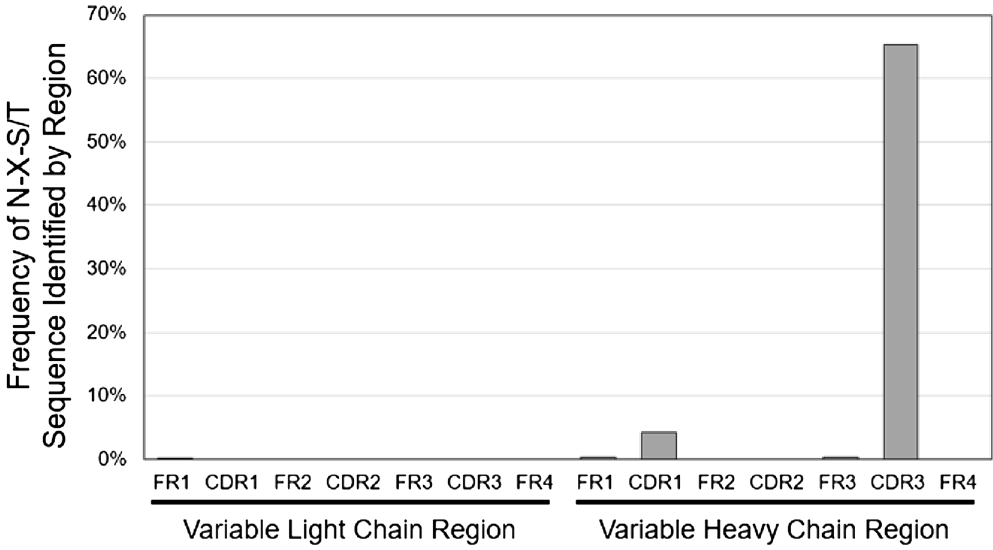
Figure 1. Frequency and location of glycosylation site sequences appearing in variable segments. Deep sequencing results of tissue sections from a follicular lymphoma involved lymph node were analyzed to reveal the region and frequency of total reads possessing an N-glycosylation site sequence N-X-S/T (where X is not Proline) suggesting that the B cells present in the section had preferential glycosylation of the CDR3